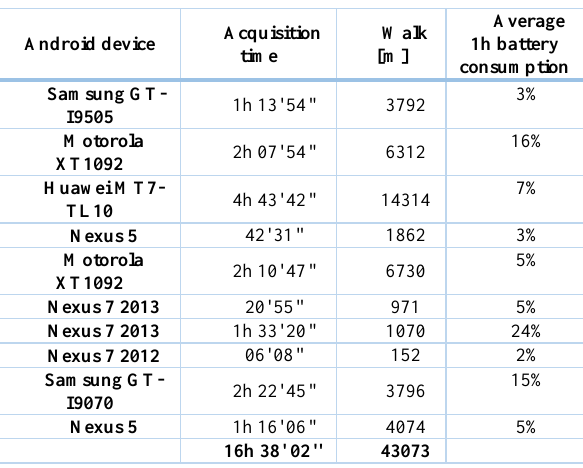
Table 1 . Average battery consumption for each device in using MEP-Traces during the experiments in Cernobbio (Como, Italy) with total acquisition time and the total length (in